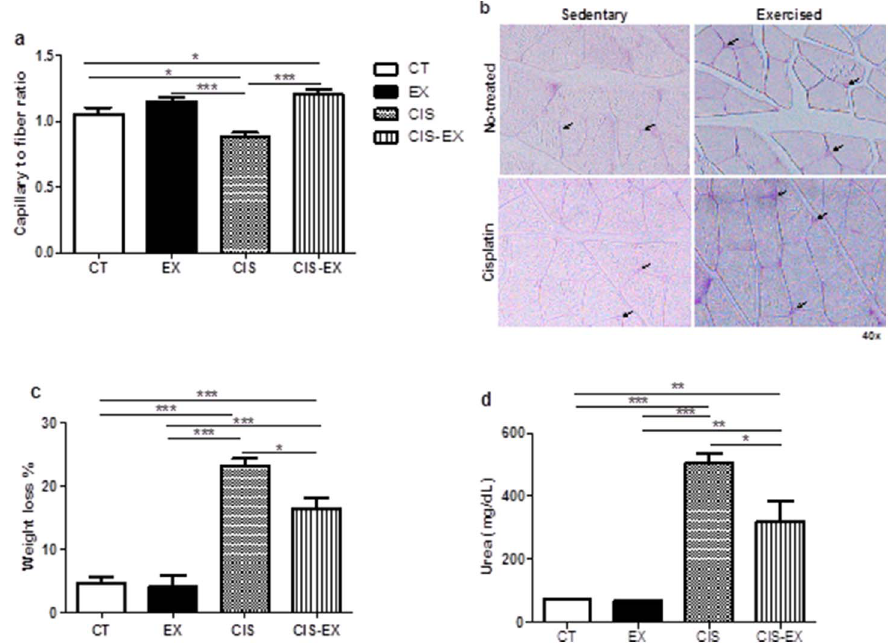
of serum urea ( D ) in the CIS-EX group compared to the sedentary goup injected with cisplatin (CIS) indicate the protective effect of exercise. The sedentary group without cisplatin injection was used as the control (CT). *P , 0.05; **P , 0.01; ***P , 0.001.